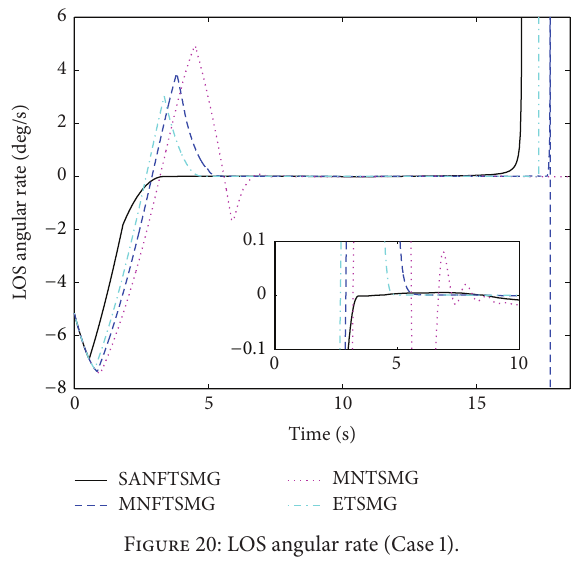
Figure 20: LOS angular rate (Case 1).